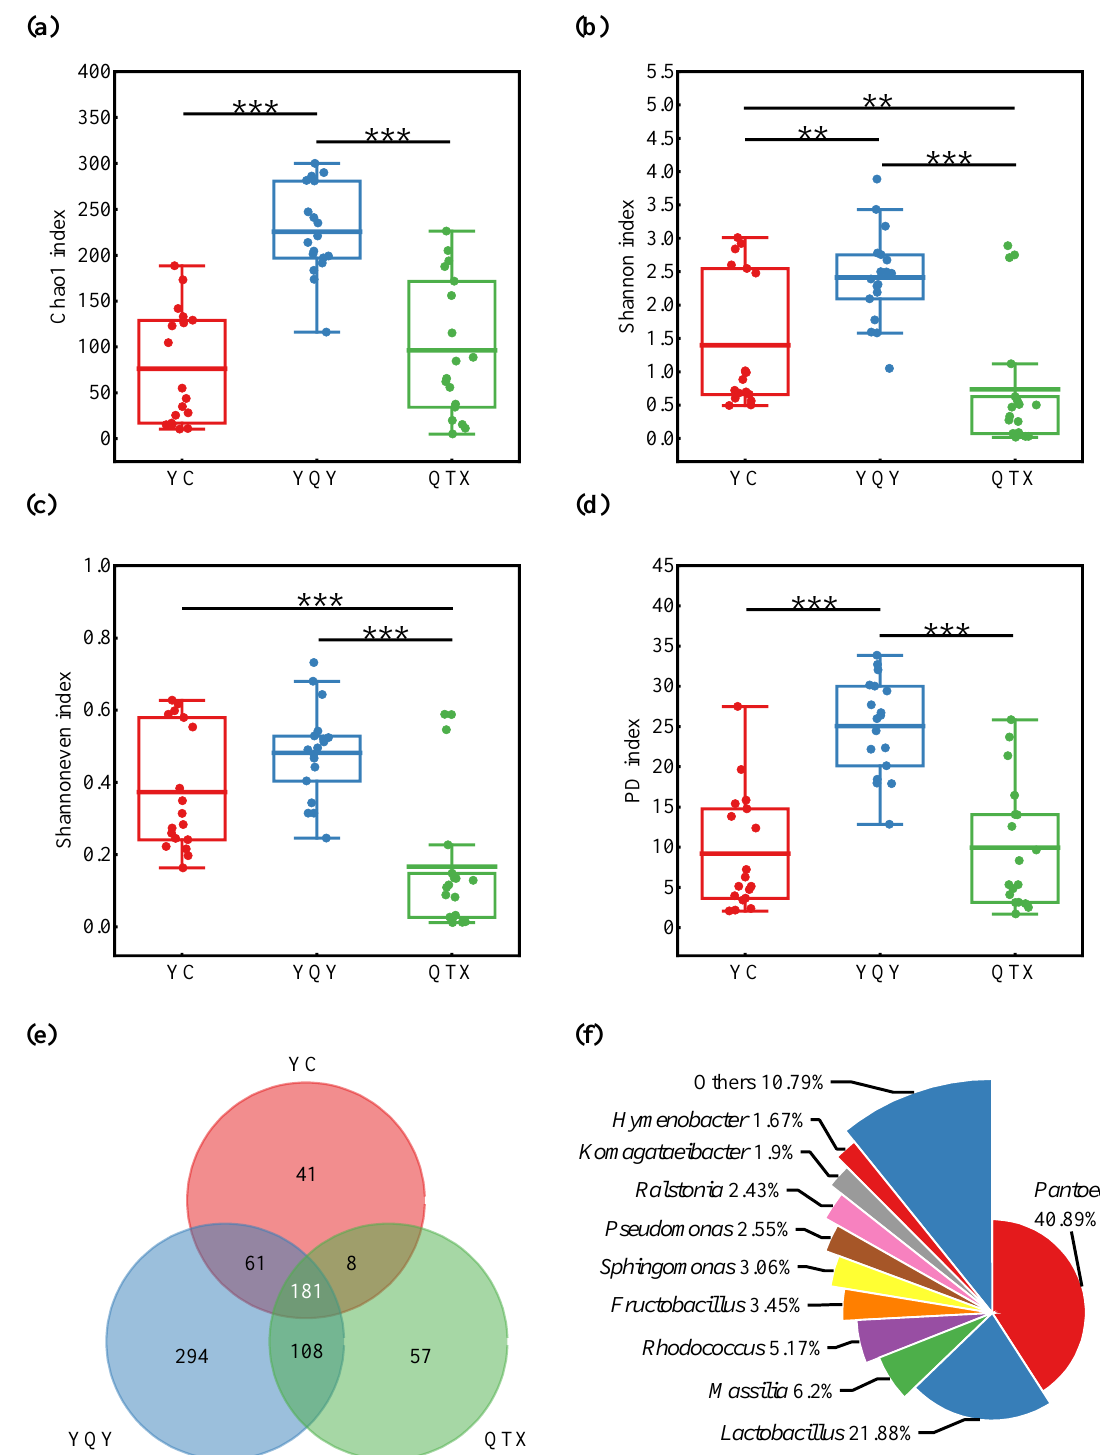
Figure 3. Bacterial diversity of different sub-regions. Alpha diversity at genus level: ( a ) Chao 1 diversity, ( b ) Shannon diversity, ( c ) Shannoneven diversity, and ( d ) Faith’s phylogenetic diversity; Alpha diversity values were calculated based on rarefied data established using 16S sequencing reads from 18 samples per sub-region; the statistical significance analysis was based on Wilcoxon rank-sum test, ** p < 0.01, *** p < 0.001; ( e ) the Venn plot of bacteria at the genus level; ( f ) the shared top 10 bacteria with a relative abundance of more than 1% at the genus level among three sub-regions.